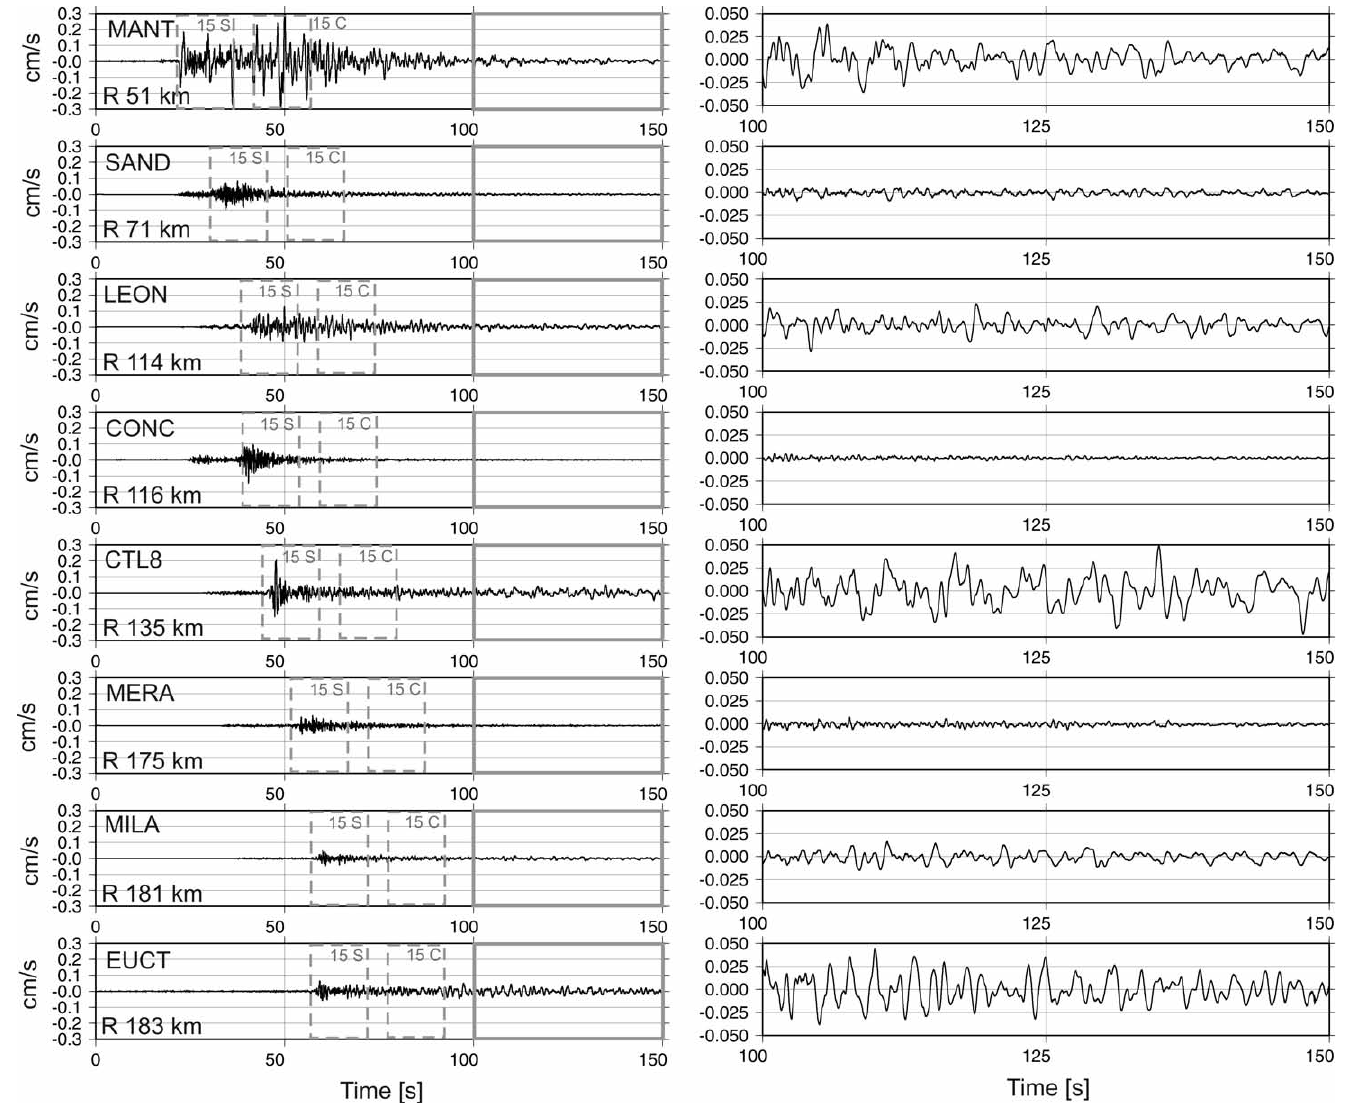
Figure 3. Velocimetric waveforms obtained after integral of the acceleration time series shown in Figure 2 for the eight RAIS strong-motion stations analyzed. Left: North-south components of the July 17, 2011, event. The gray dashed inset define portions of the signals (15 s of S and coda phases) considered during the spectral analysis. Right: Particular of coda windows indicated by the gray solid inset in the left